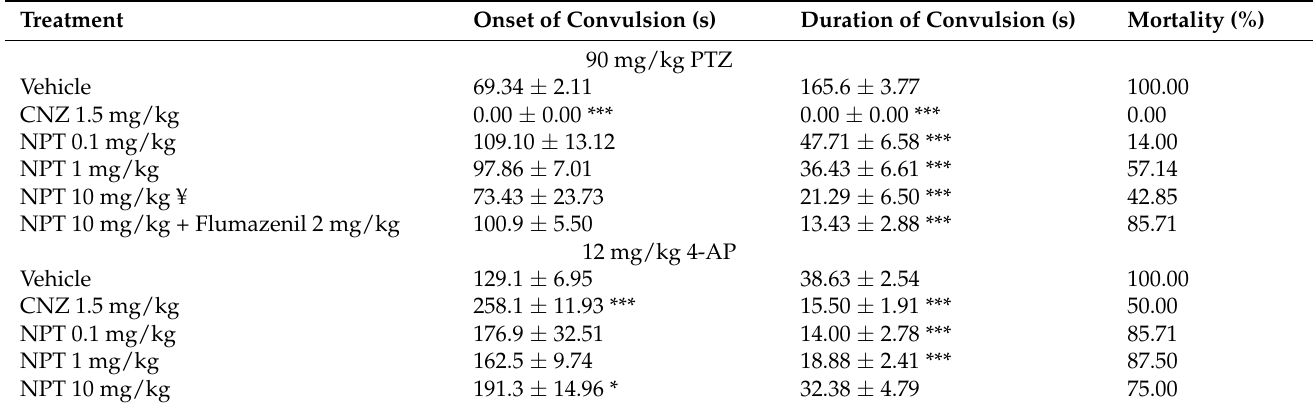
Table 2 . Anticonvulsant activity of NPT in mice treated with 90 mg/kg pentylenetetrazole (PTZ) or 12 mg/kg 4-aminipyridine (4-AP) to induce convulsions . Table 2. Anticonvulsant activity of NPT in mice treated with 90 mg/kg pentylenetetrazole (PTZ) or 12 mg/kg 4-aminipyridine (4-AP) to induce convulsions.